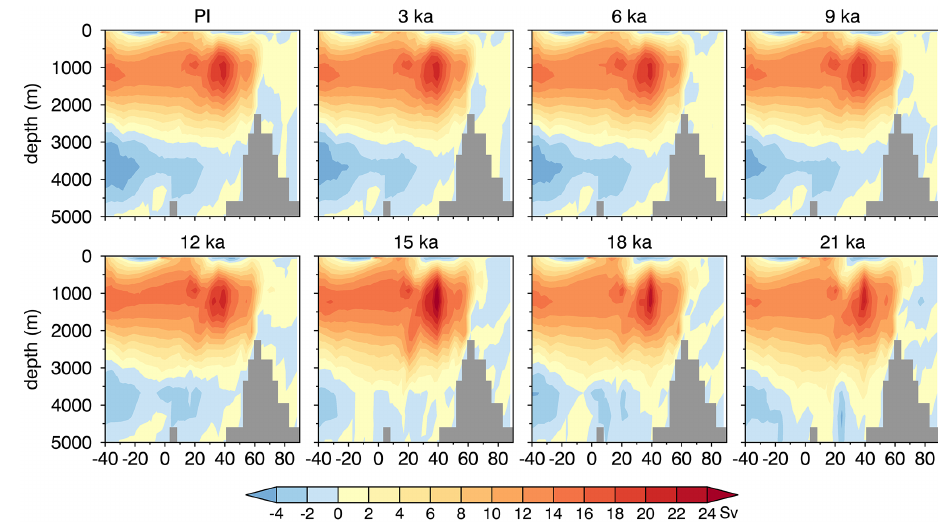
Figure 12. Simulated annual average Atlantic Meridional Overturning Circulation (AMOC) for the eight time slices.